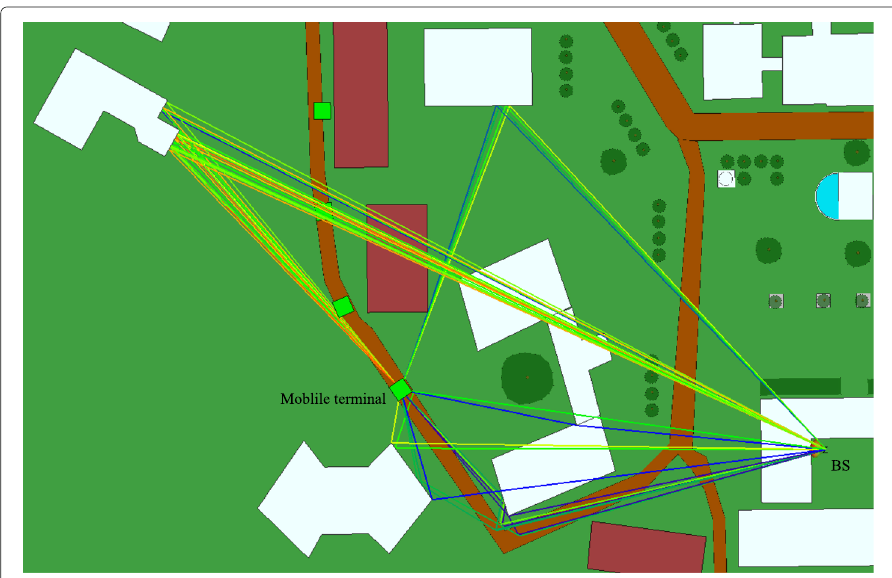
Fig. 16 Simulation ray by the Wireless Insite